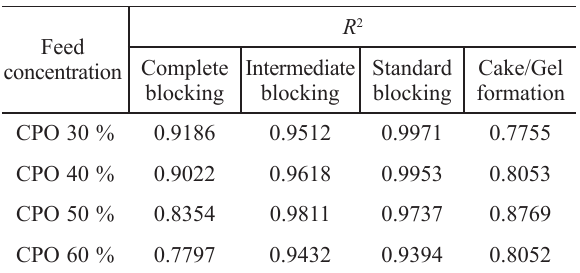
Fig. 7 – Fitting of experimental data (feed temperature: 30 °C, pressure: 1 bar) to Hermia’s model: (a) complete blocking, (b) standard blocking, (c) intermediate blocking, and (d) cake/gel layer formation Table 5 – R 2 values of the blocking mechanism based on Hermia’s